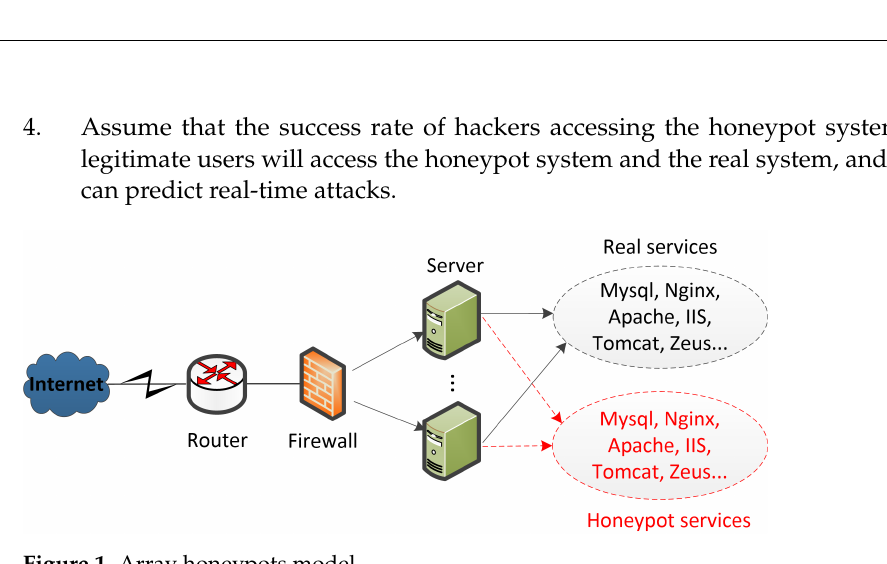
Figure 1. Array honeypots